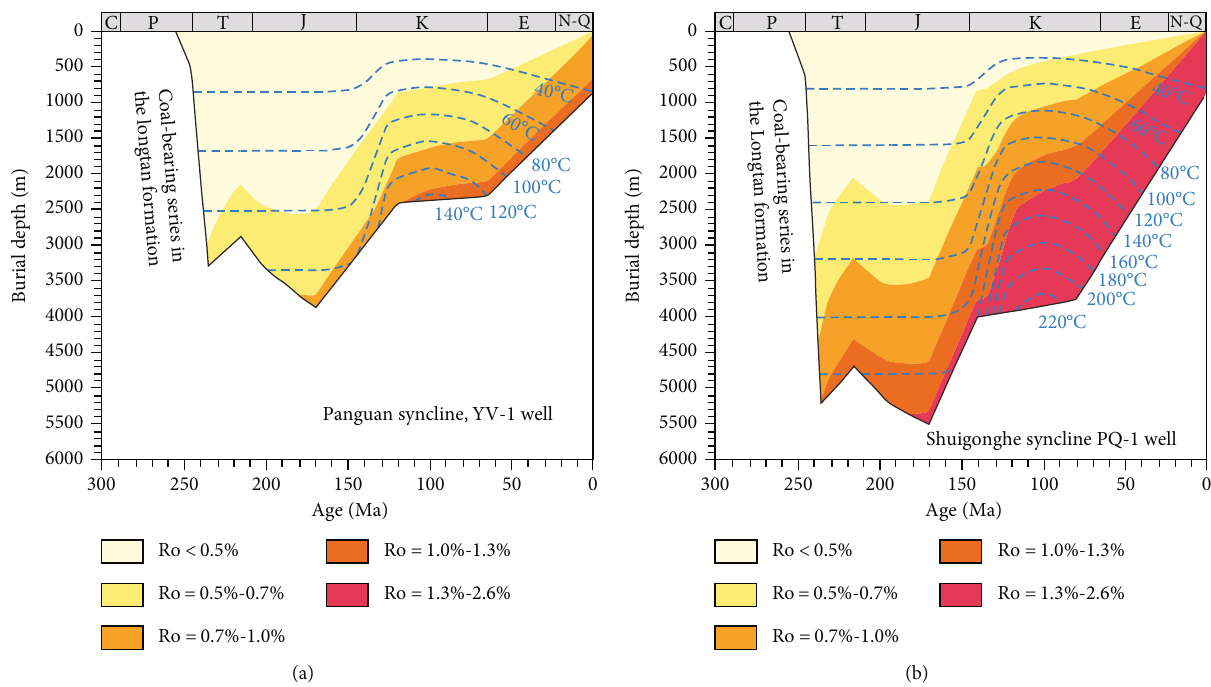
Figure 2: Burial history and thermal maturation process of coal seams in the Upper Permian Longtan formation. (a) Panguan syncline; (b) Shuigonghe syncline (modi fi ed from